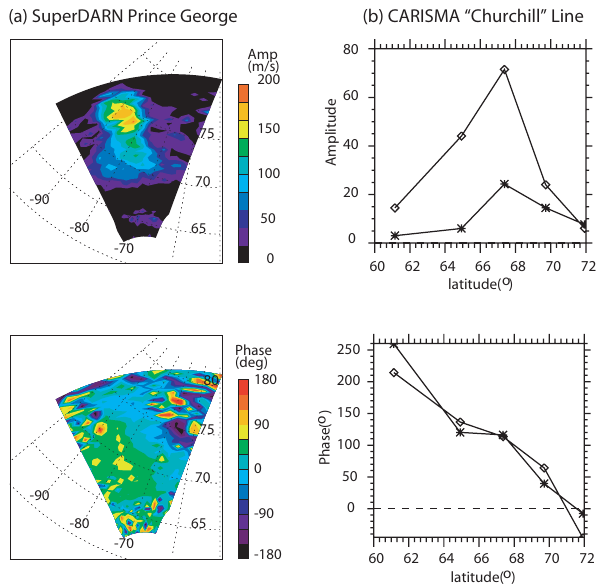
Fig. 4. (top) the amplitude and (bottom) phase of the 1.5mHz com- ponents of (a) the SuperDARN Prince George radar l-o-s velocities, and (b) the H- (diamonds) and D- (stars) component magnetometer data from the Churchill line